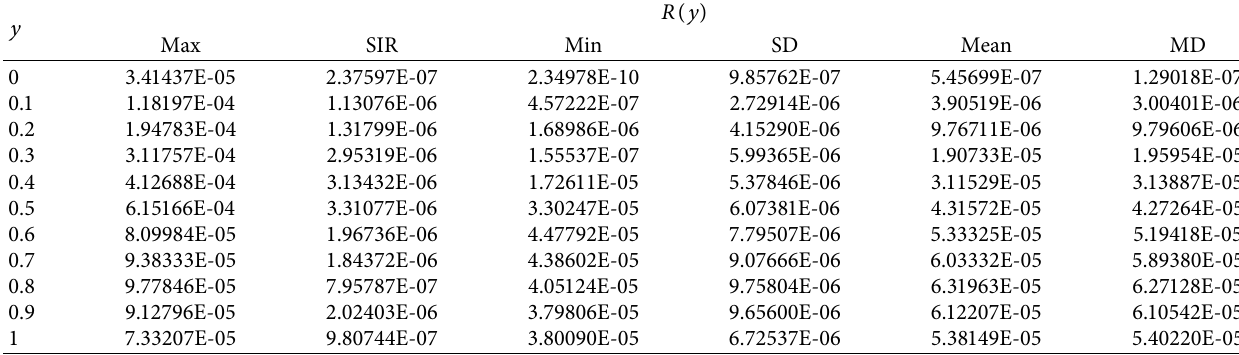
Table 5: Statistical performances for the class R ( y ) to solve the mathematical SEIR-NDC